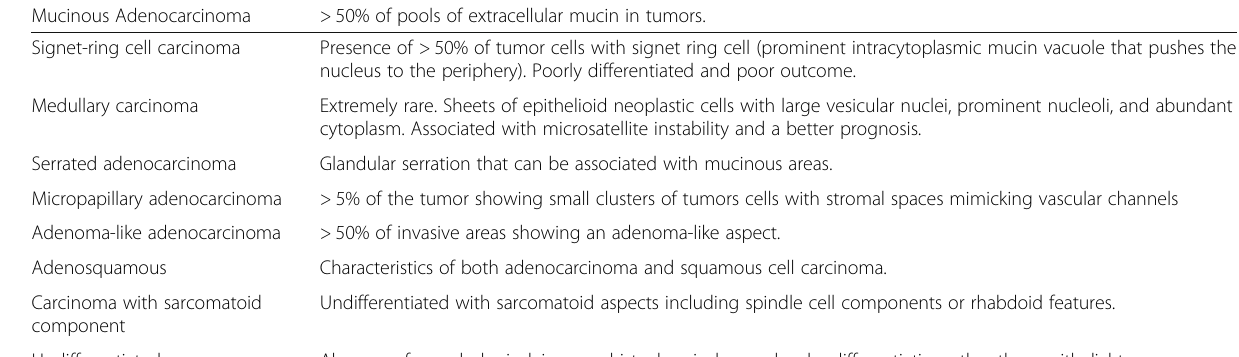
Table 1 Histological subtypes of colorectal adenocarcinoma, adapted from the 5th edition of the World Health Organization (WHO) classification of tumors of the digestive system [24] Mucinous Adenocarcinoma > 50% of pools of extracellular mucin in